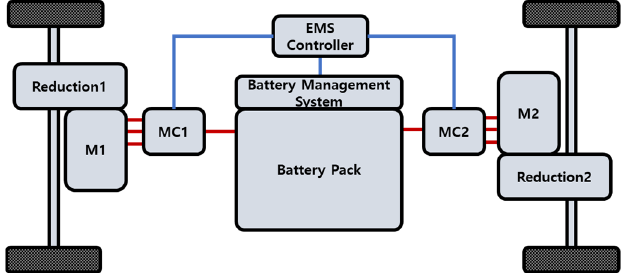
Figure 2. Target EV structure based on dual motor type 4WD drive system. Table 1. Specification of 120 kW target electric vehicle.